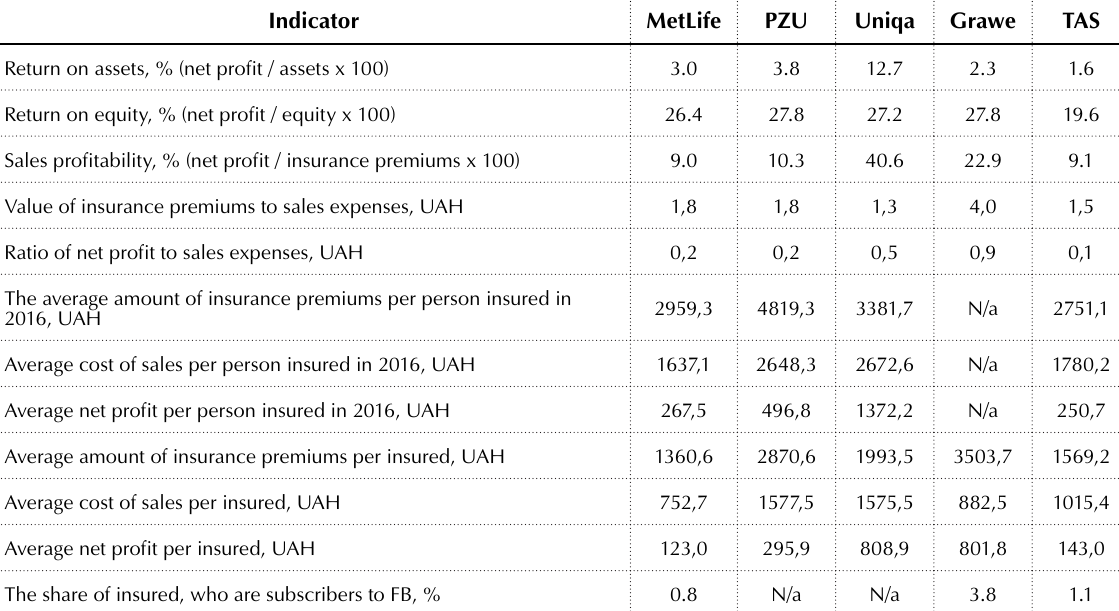
Table 10. Indicators of the economic efficiency of marketing activities of life insurance companies in Ukraine as of January 1, 2017 Indicator